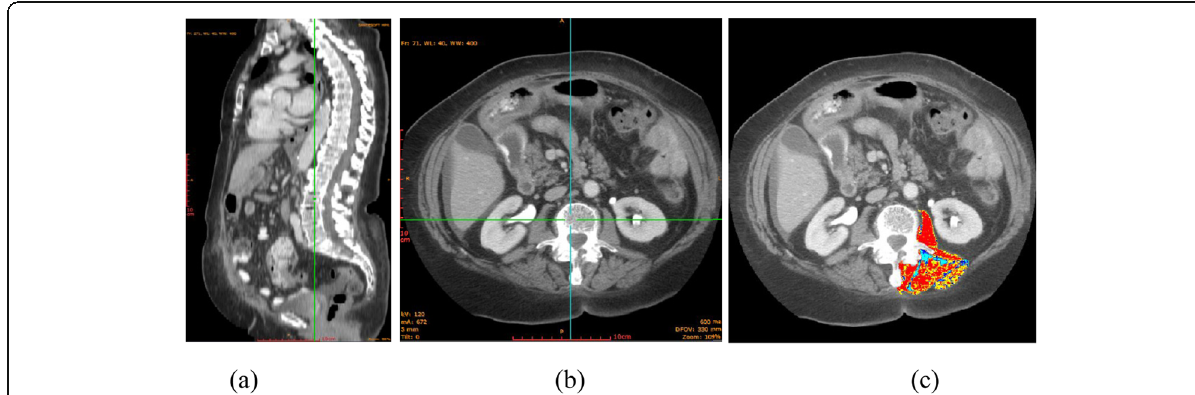
Fig. 6 Identifying the level (L3) of vertebral spines in ( a ) the sagittal and ( b ) axial views and ( c ) the segmented TPA and its surrounding muscle region where the color indicates the heterogeneity of muscle